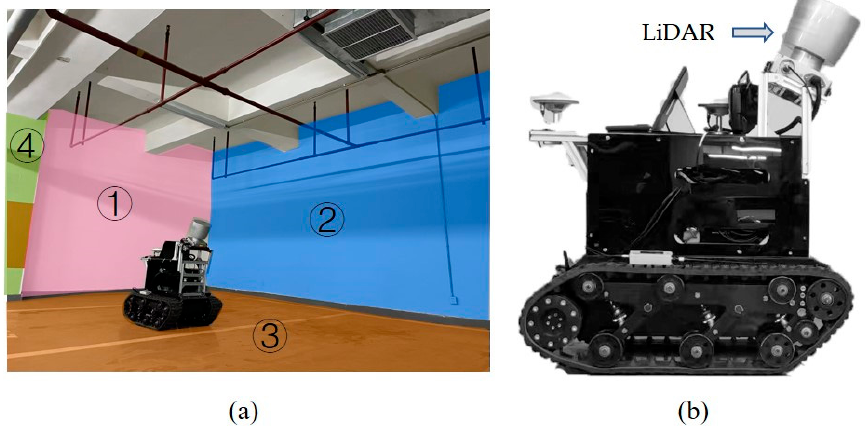
Figure 7. The experimental environment. ( a ) The flat walls scanned by LiDAR. ( b ) The pose of LiDAR mounted on our mobile platform.